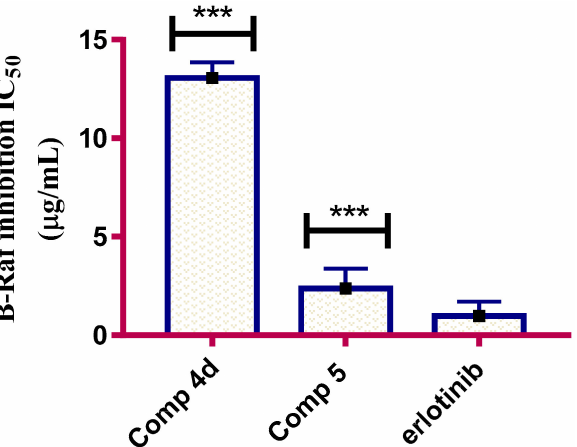
Figure 5. A graphical representation of the IC 50 values ( µ g/mL) of compounds 4d , 5, and erlotinib for the B-Raf enzyme. Data are expressed as mean ( n = 3 experiments) ± SEM and statistical comparisons were carried out using one-way analysis of variance (ANOVA) followed by Tukey’s multiple comparisons test (***, p <